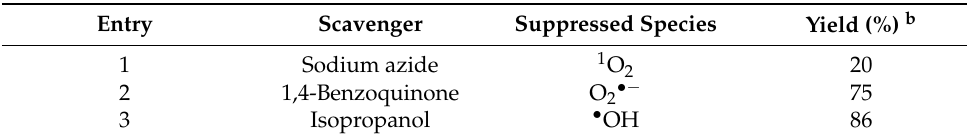
Figure 7. ( a ) Probable mechanism of the tandem process of photocatalytic alcohol oxidation/Knoevenagel condensation promoted by Porph-UOZ-COF as photocatalyst and ( b ) EPR spectra of TEMPO generated by 1 O 2 oxidation of TEMP under visible light irradiation. Table 4. Inhibition tests to understand the nature of oxygen species a